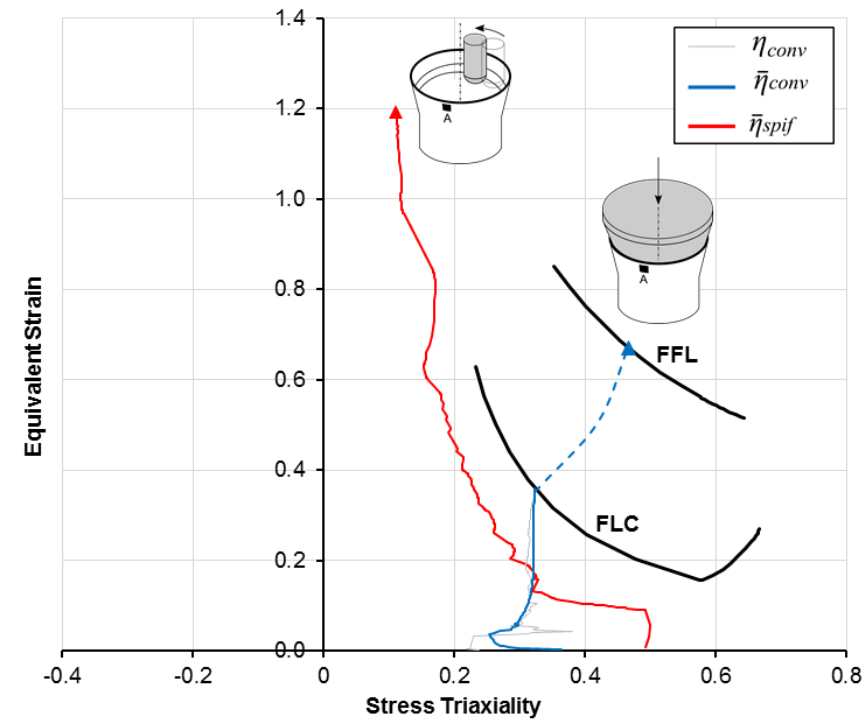
Figure 14. Finite element computed evolutions of the loading paths experienced by a point A lo- cated 1.5 mm away from the upper tube end in incremental and conventional tube expansion processes. Note: the red and blue triangular markers correspond to the experimentally determined “gauge length” strains at fracture.